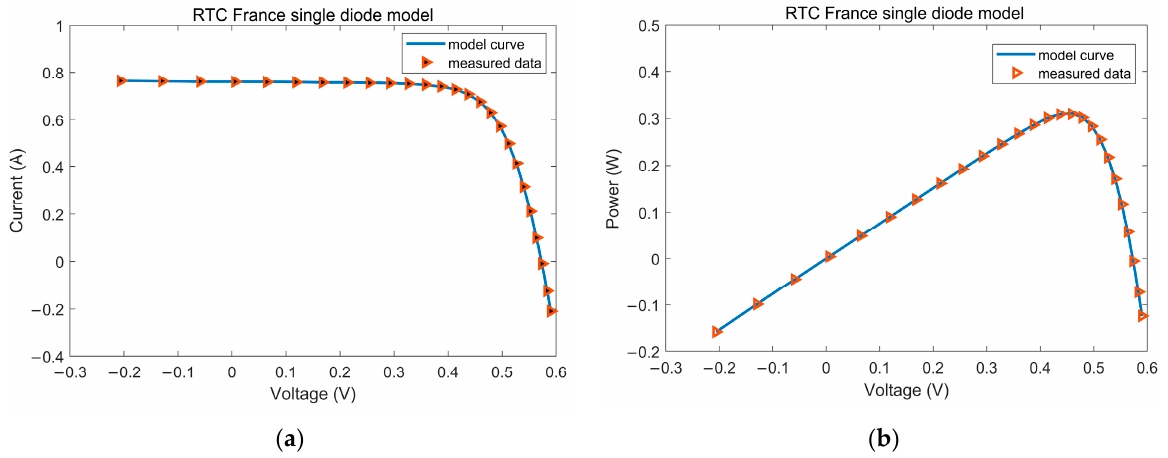
Figure 17. Fitting curves between the measured data and estimated data obtained by CHAOARO on the SDM. ( a ) I - V characteristics; ( b ) P - V characteristics.